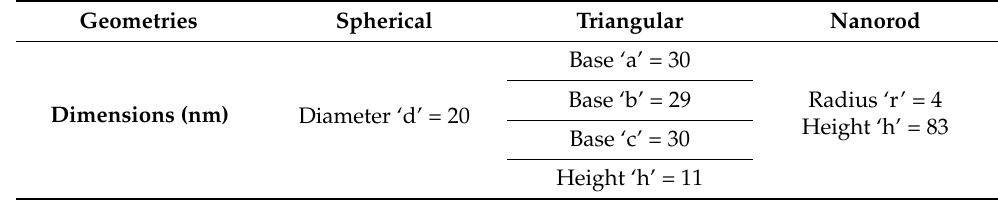
Table 1. Dimensions of spherical, triangular and nanorod geometries for aluminum plasmonic